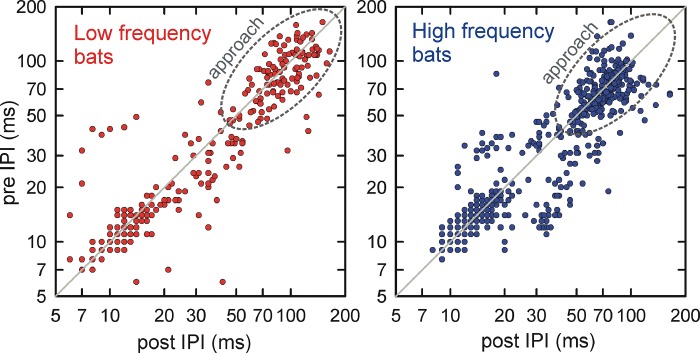
Contingency relation between IPI before and IPI after each pulse.When flying in the open with few nearby obstacles, a cruising bat emits pulses with regular IPIs, illustrated by about equal values of pre IPIs and post IPIs (that is, values clustered along the diagonal lines of pre IPI to post IPI plots). IPIs used during approach to drinking by both low-frequency and high-frequency bats are indeed clustered along the diagonal lines (dashed circles) in a time region from 50 to 75–100 ms, indicating that pre-IPIs and post-IPIs in approach are about equal. Separate diagonal clusters between 10 and 20 ms define the drinking buzzes.